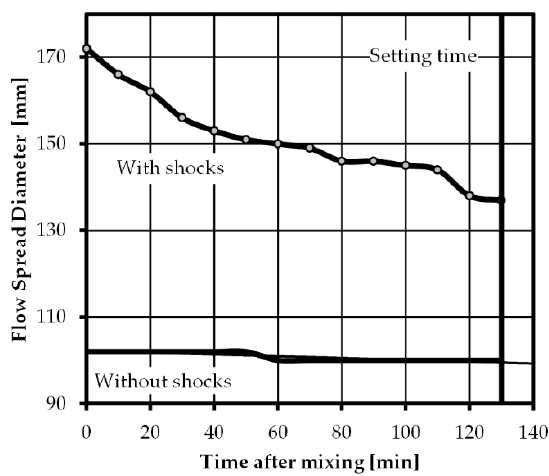
Figure 2. Development of spread diameter of Hägermann flow table test with increasing time after mixing solid components with water.